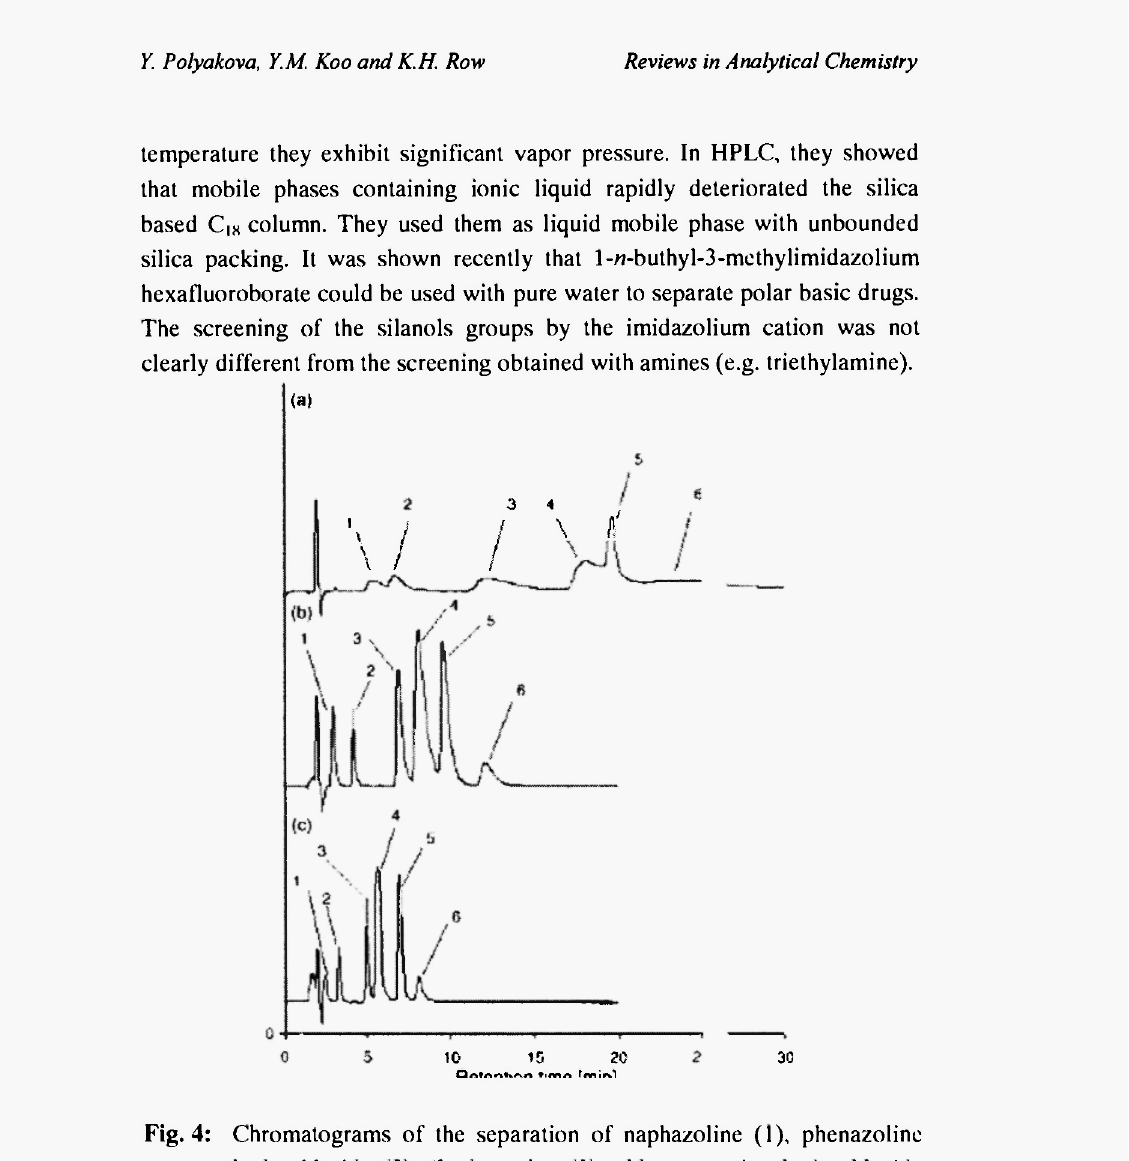
Fig. 4: Chromatograms of the separation of naphazoline (1), phenazoline hydrochloride (2), tluphenazine (3), chlorpromazine hydrochloride (4), trifluopromazine (5), and thioridazine hydrochloride (6): (a) acetonitrile: phosphoric buffer (pH 3) 50/50 (% v/v) as the mobile phase; (b) acetonitrile: phosphoric buffer (pH 3) 50/50 (% v/v) with the addition of 0.05% (v/v) 1,3-dimethylimidazolium methyl sulfate: (c) acctonitrile: phosphoric buffer (pH 3.0) 50/50% (v/v) with the addition of 0.5% 1,3-dimethylimidazolium methyl sulfate (reprinted with permission from Ref.